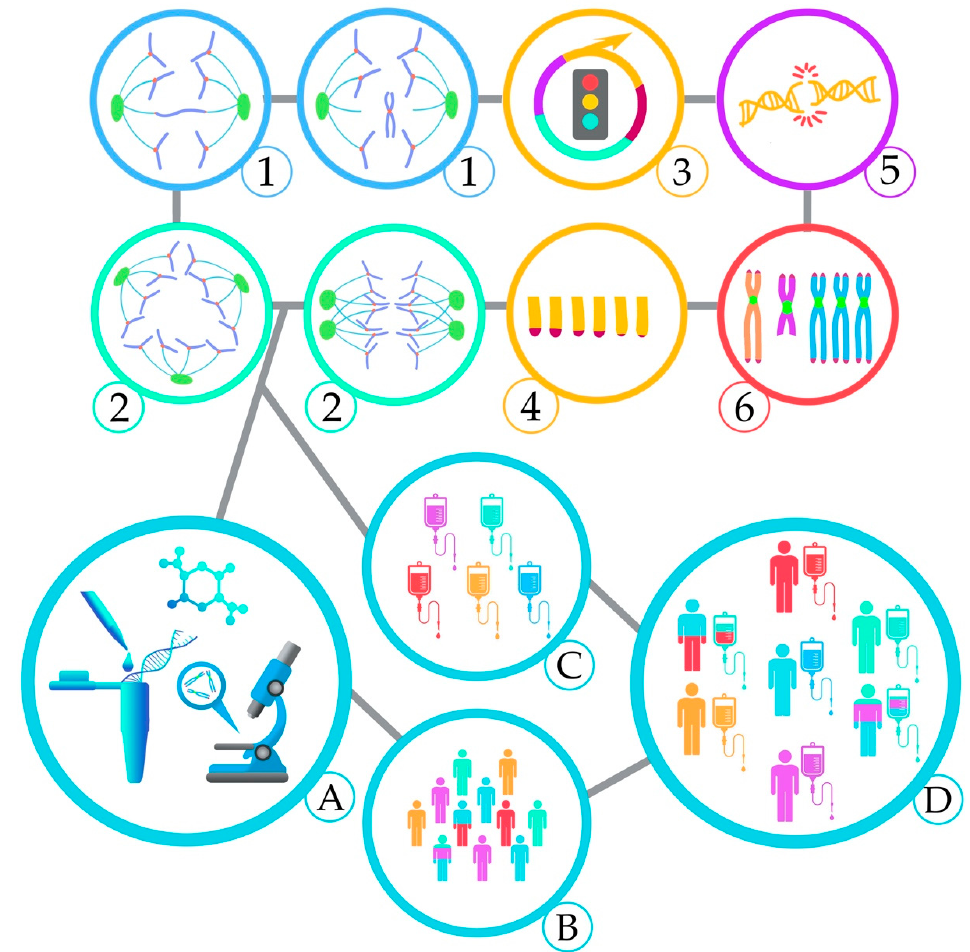
Figure 2. AML patients can present various CIN features, such as Chromosome mis-segregation (1); Multipolar spindles (2); Dysfunctional cell cycle checkpoints (3); Telomere dysfunction (4); Defective DNA damage response (5); Chromosomal abnormalities associated with CIN (6). These unique CIN markers could be used in clinical practice (A) for better stratification of patients with complex karyotype (B) and combine new target therapies (C) for personalized treatments (D).